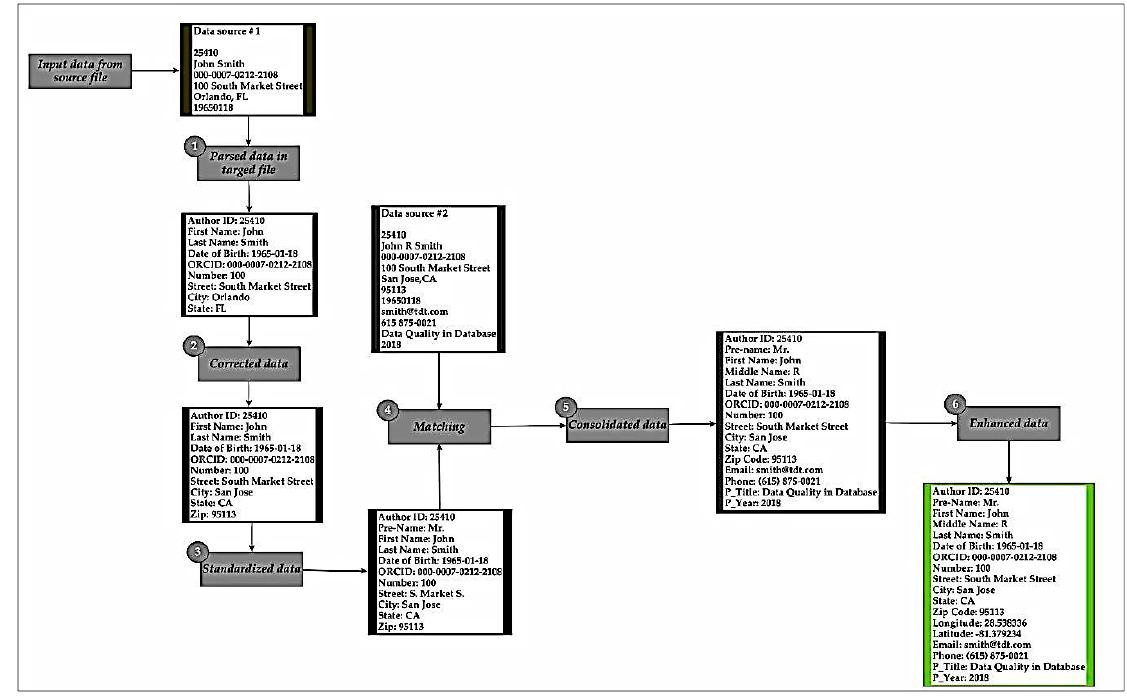
Figure 10. Examples of data cleansing processes in the context of CRIS.